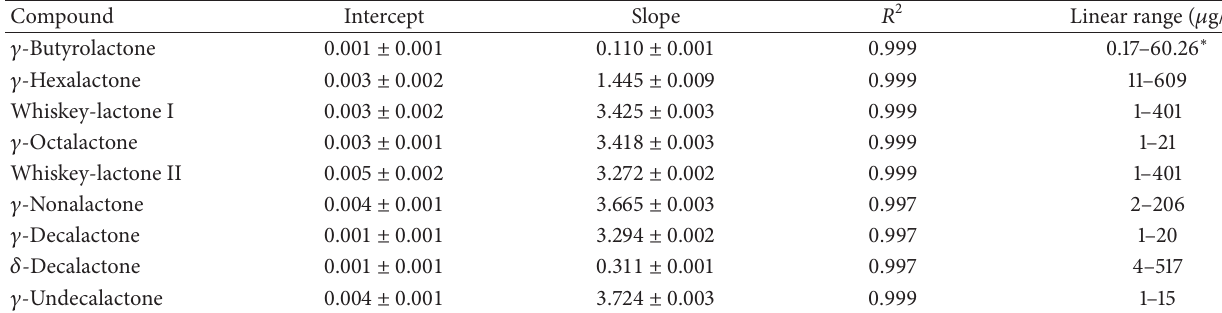
Table 5: O.O, slope, 𝑅 2 , and linear range of lactones ( 𝑛 = 8 ).